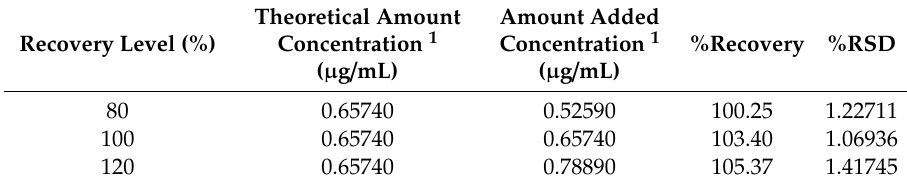
Table 6. Evaluation data of recovery studies using UV–vis